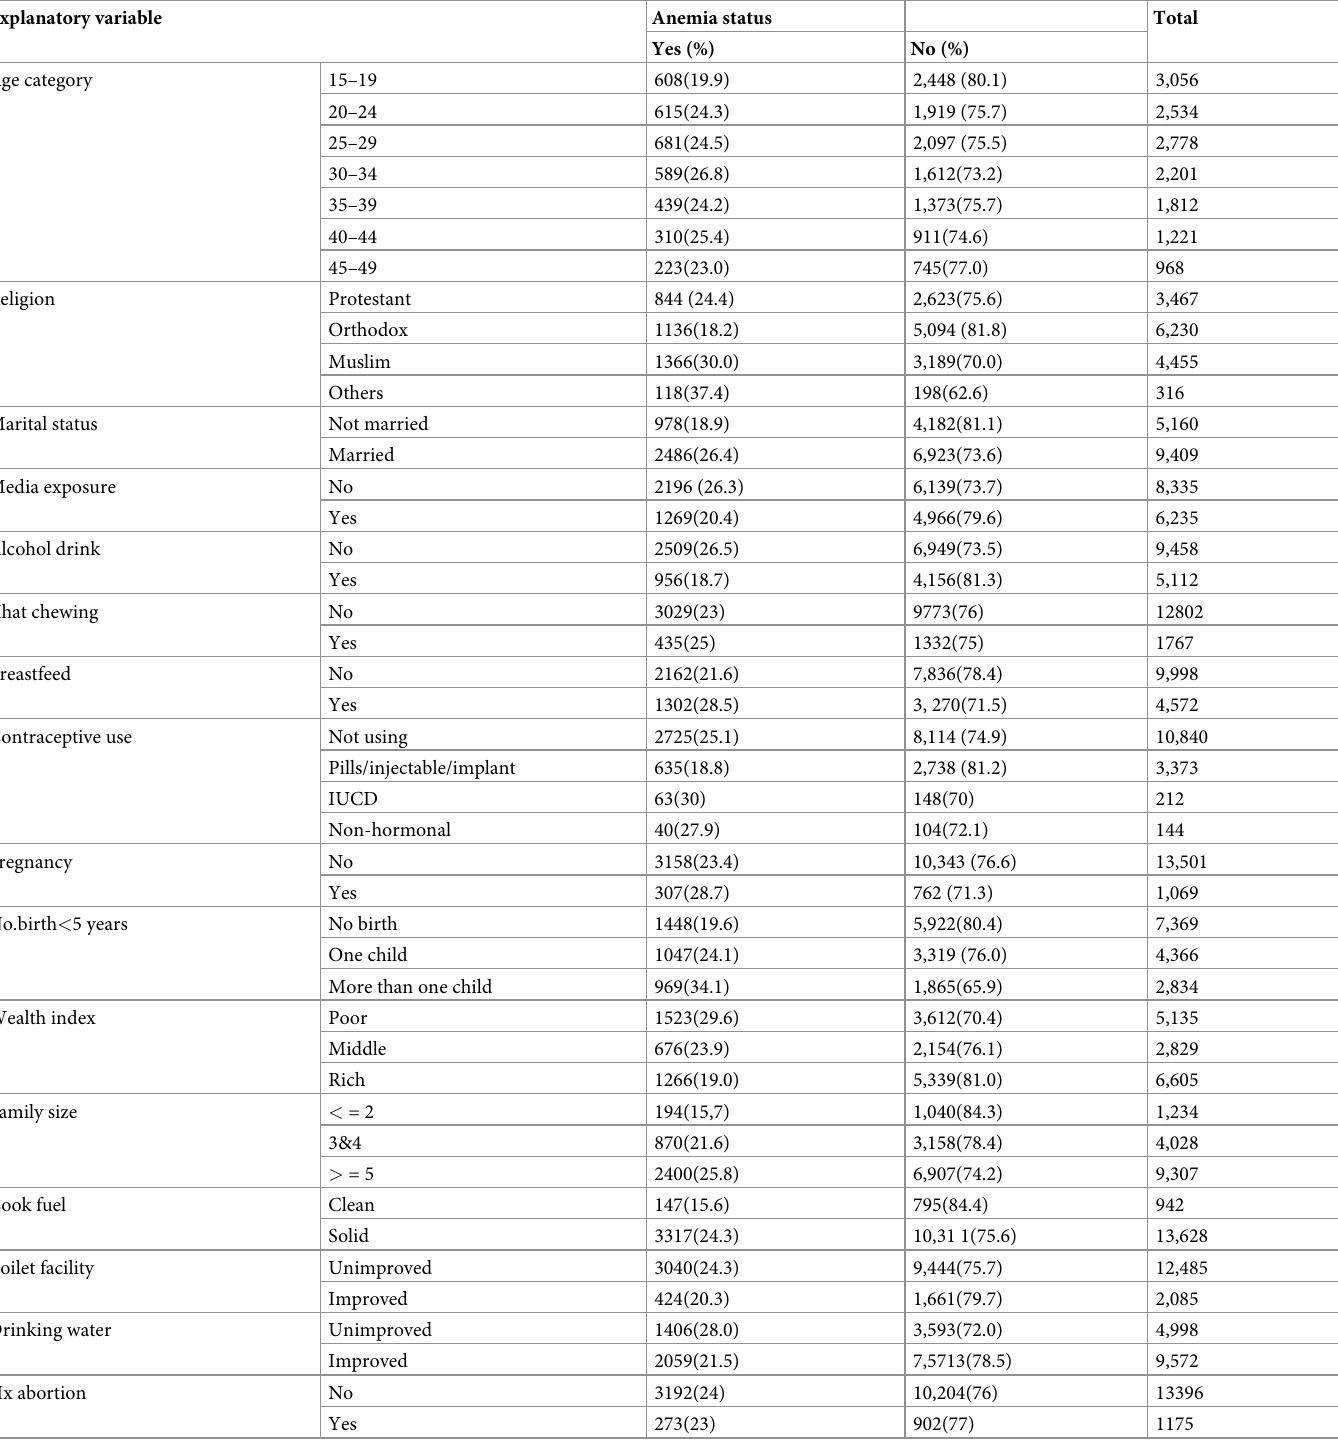
Table 1. Prevalence of anemia among WRA with sociodemographic characteristics, 2016